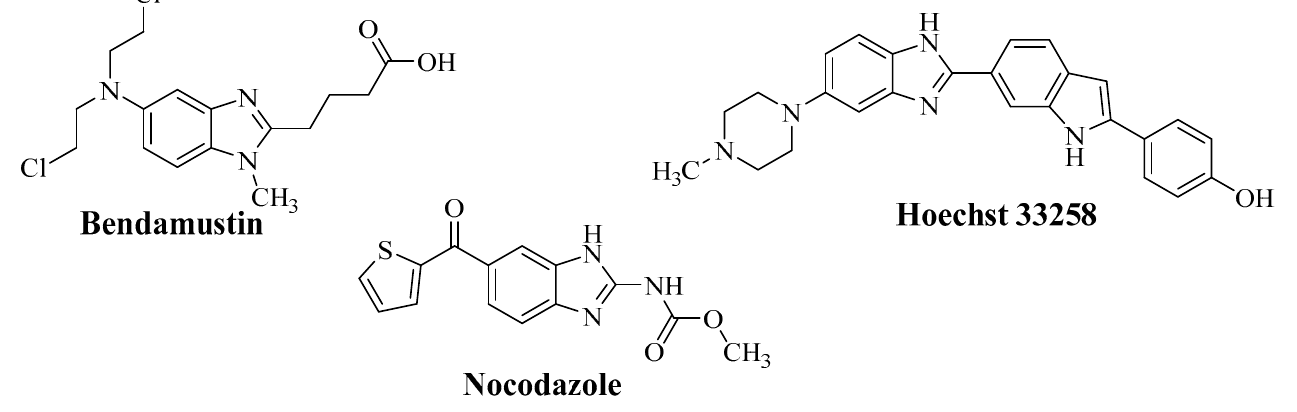
Figure 1. Drugs containing benzimidazole moiety.